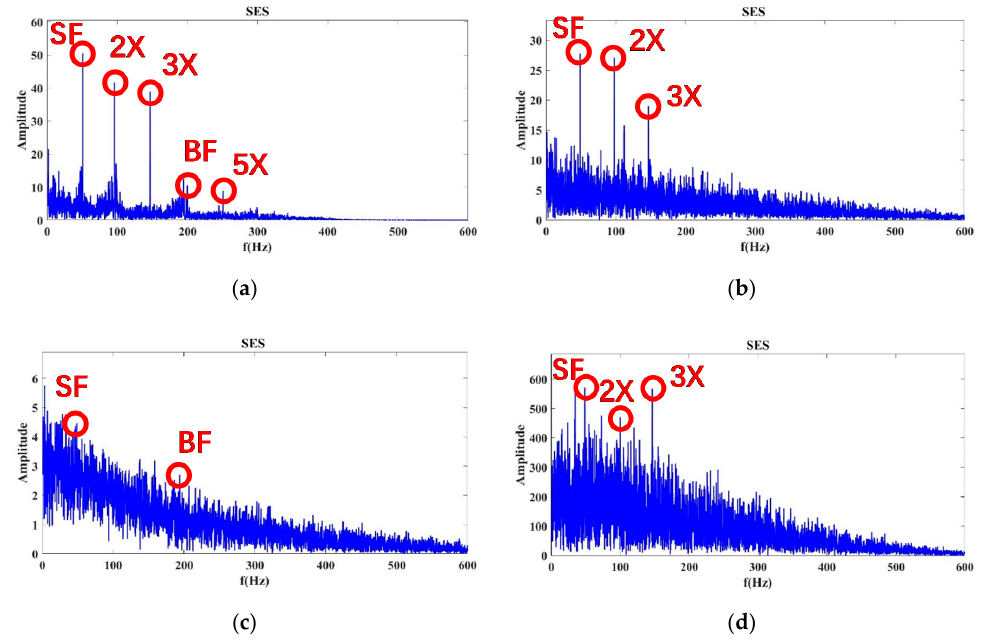
Figure 8. SES spectrum of the Autogram at a 100% flow rate at the accelerometer ID 15 (Sensor 15): ( a